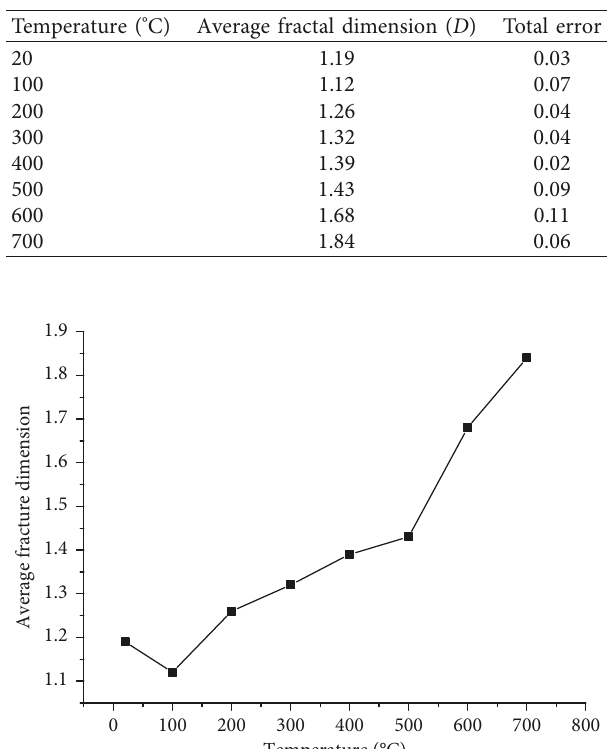
Table 4: Average fractal dimension values of crack development paths under different temperatures.